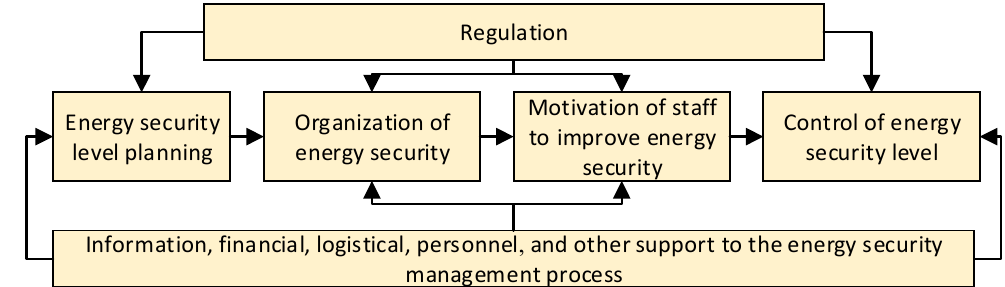
Fig. 1: Energy security management based on a functional approach